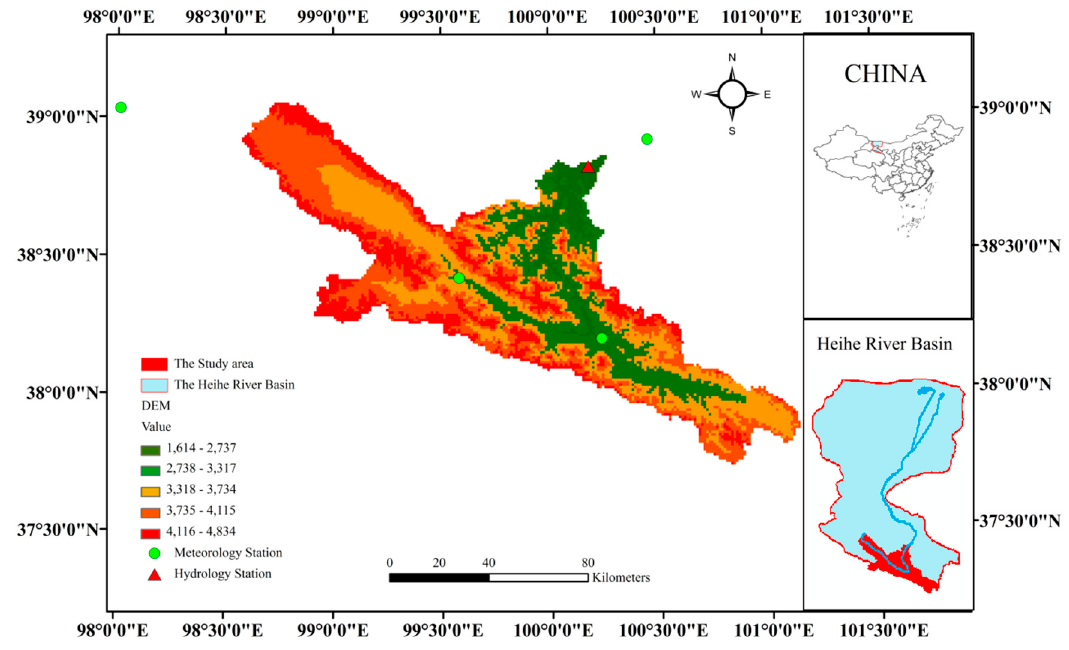
Figure 1. Upper reaches of the Heihe River Basin.